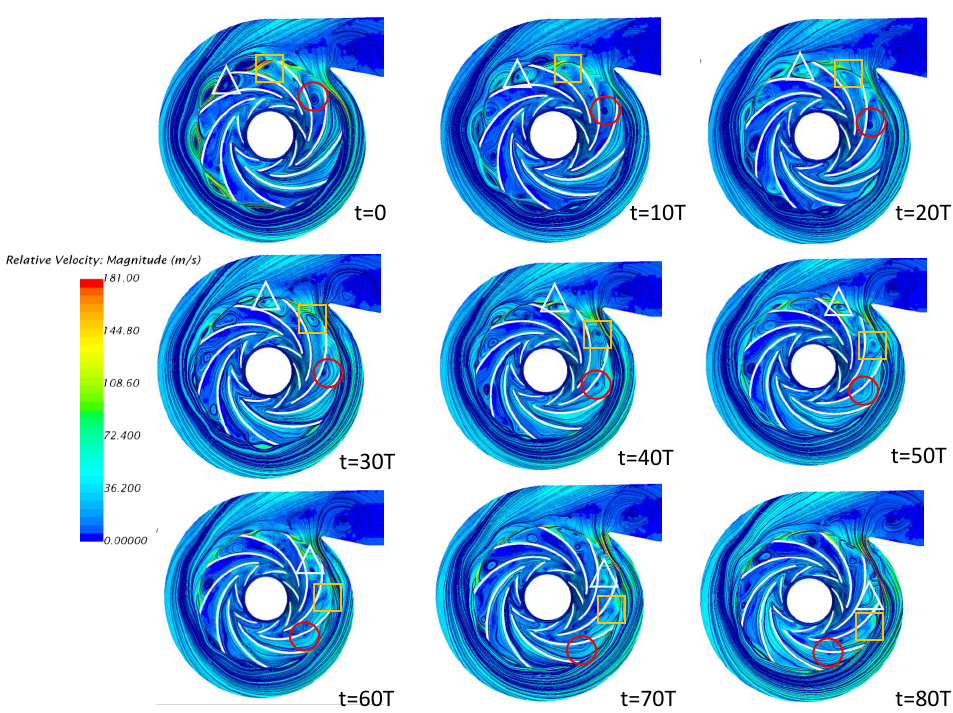
Figure 14. Streamline patterns of different time-step at ESP. Beside that, the difference of blade number as well as the change of rotation speed of each impeller leads to a variation in blade pitch between adjacent blade rows. The pressure signal is taken by a pressure probe located between the trailing edge of the upstream impeller and the leading edge of the downstream impeller. The Fast Fourier Transform (FFT) is applied to pressure signals to observe Blade Passing Frequency (BPF). The